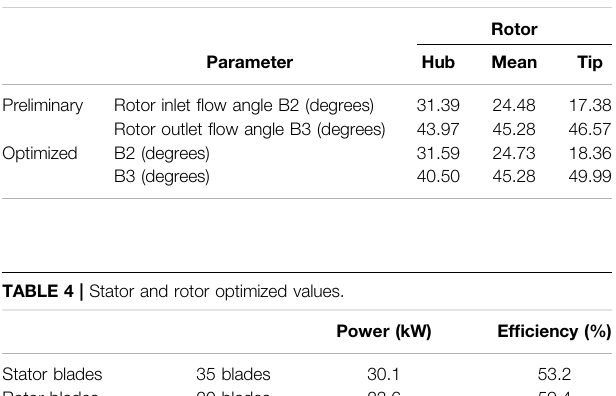
TABLE 3 | Rotor main geometric and fl ow angle data.